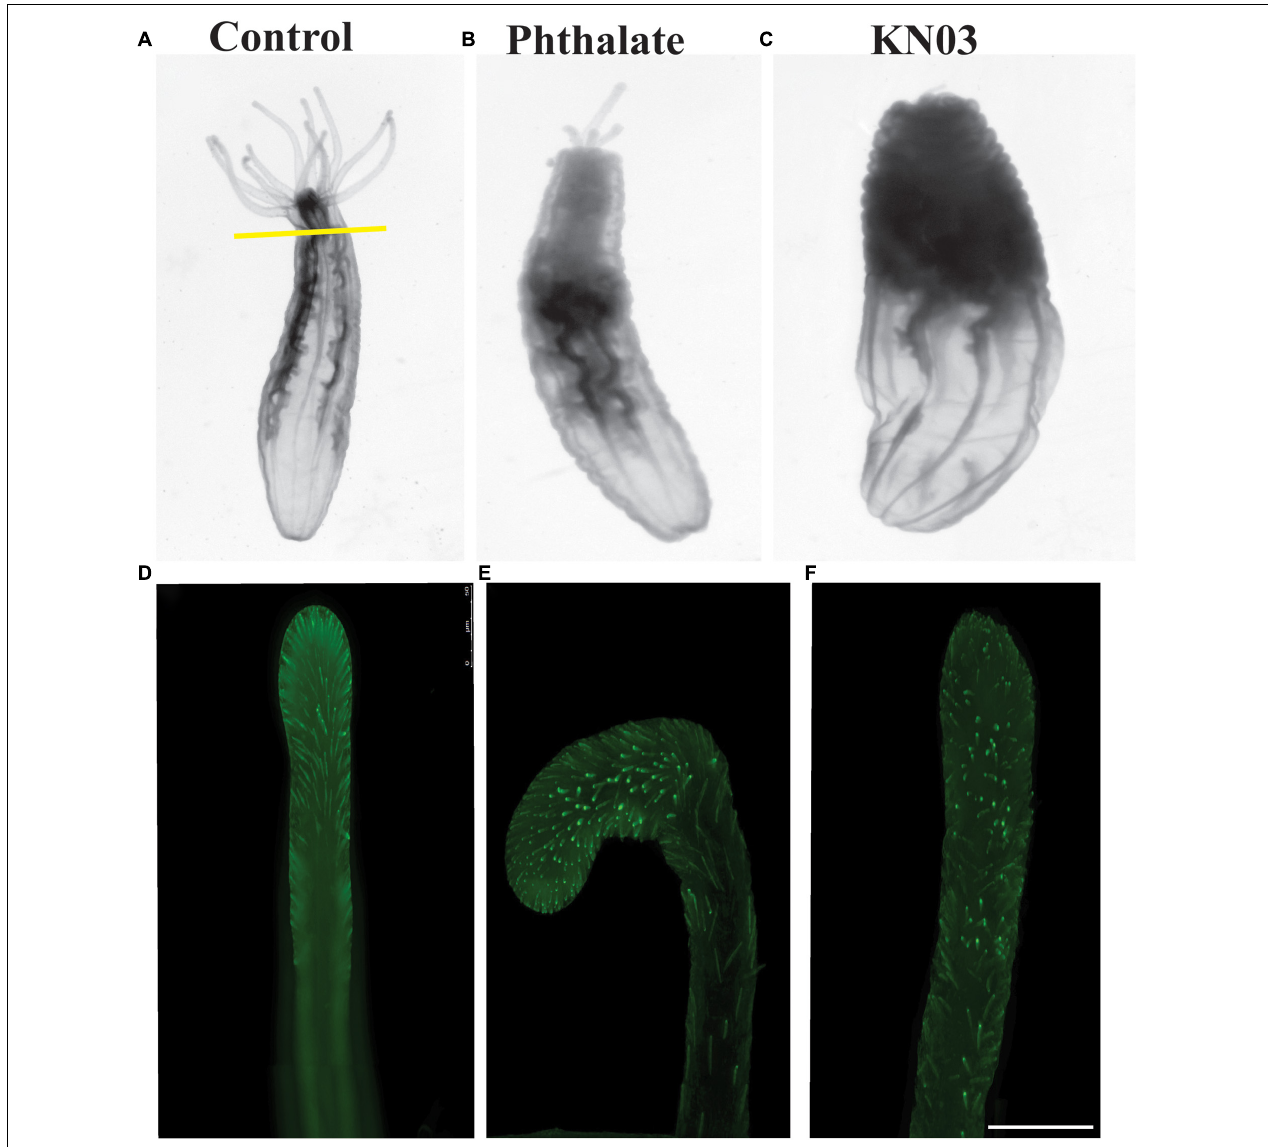
FIGURE 5 | Common environmental stressors inhibit oral regeneration. Nematostella can regenerate throughout life. Adult animals were amputated through the pharynx and assessed for completion of oral regeneration 2 weeks post injury. (A) Control animals regenerated all tentacles ( n = 85). (B) Animals exposed to phthalates at 20 µ M failed to regenerate tentacles of the correct length ( n = 90). In contrast animals exposed to KNO 3 during regeneration mainly failed to regenerate tentacles, occasionally one tiny tentacle was regenerated (C) ( n = 95). Staining of cnidocytes revealed that control animals fully regenerate the cnidocytes within 2 weeks (D) , while animals exposed to phthalates or KNO 3 have very few cnidocytes on the limited tentacles that are regenerated (E,F) . (D–F) Scale bar = 50 µ